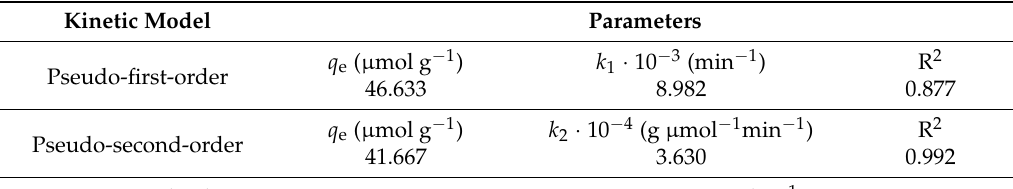
Table 1. Kinetic parameters of two models.